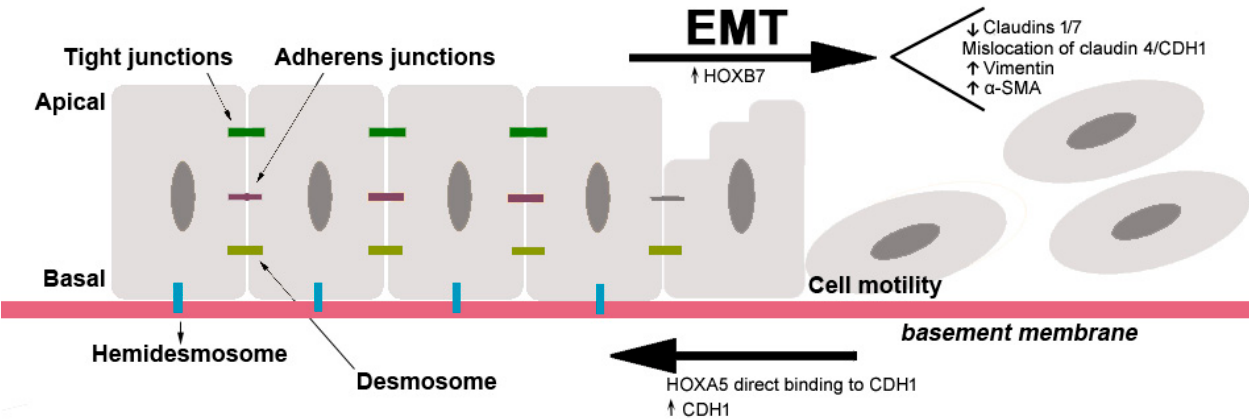
Figure 4. Examples of HOX genes involved in the activation or inhibition of the epithelial to mesenchymal transition (EMT) in breast cancer. Epithelial cells present apical–basal polarity and are maintained together by tight junctions, adherens junctions and desmosomes. Hemidesmosomes maintain epithelial cells together with basement membrane. At the end of this process, epithelial cells present mesenchymal characteristics as the absence of apical–basal polarity and presence of motility capacity. HOXA5 is known to inhibit the EMT via upregulation of CDH1 in the adherens junctions, while HOXB7 induce the EMT downregulating the epithelial proteins: Claudin-1, Claudin-7, Claudin-4 and CDH1, and upregulating vimentin and α -SMA.